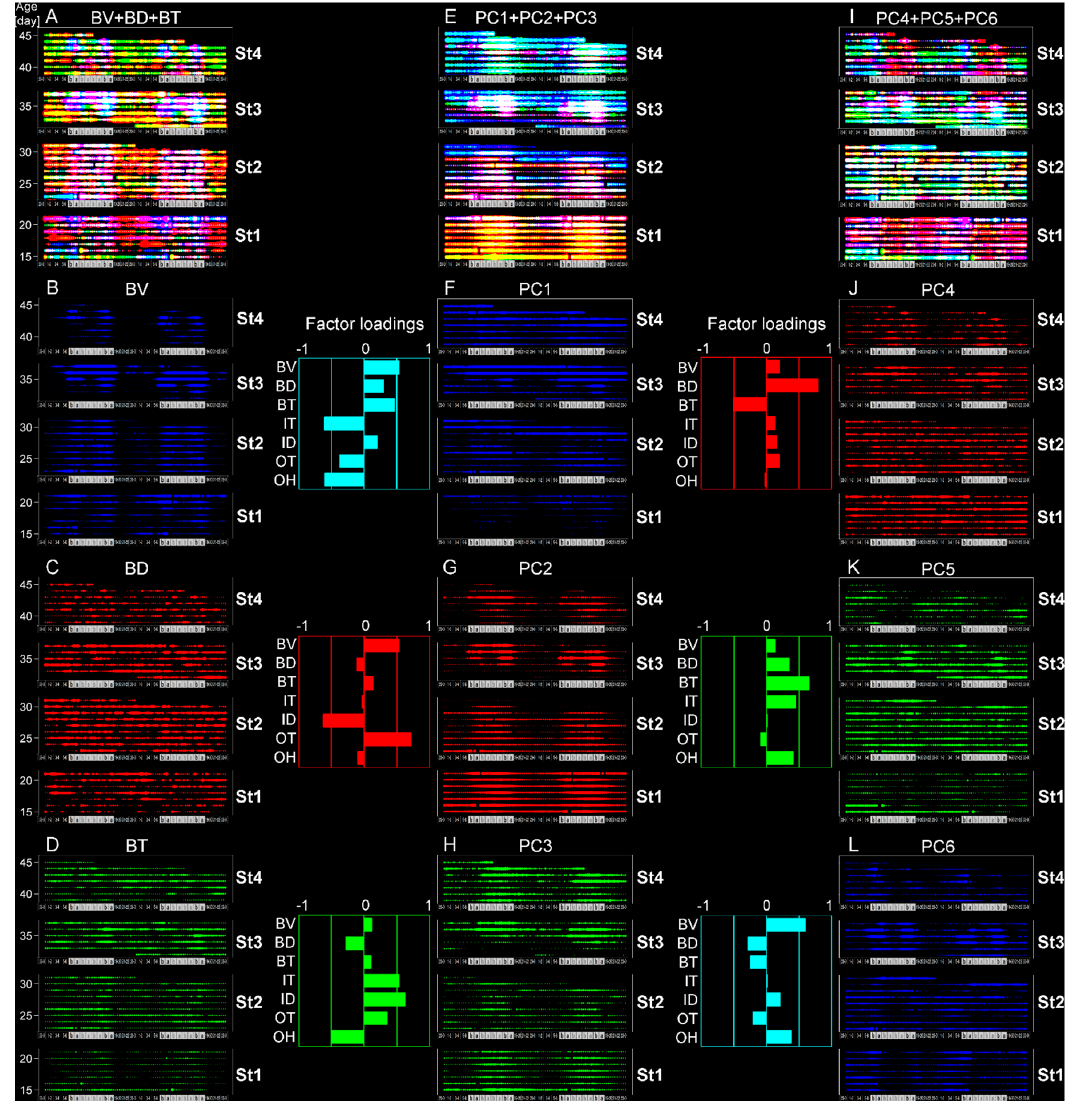
Figure 12. Characterization of complex circadian rhythms. Overlaid raster plots of BV (( B ), blue), BD (( C ), red) and BT (( D ), green), or PC1 (( F ), blue), PC2 (( G ), red) and PC3 (( H ), green), or PC4 (( J ), red), PC5 (( K ), green) and PC6 (( L ), blue) are depicted in ( A ), ( E ) or ( I ), respectively. Last, we compared the relevant B- to BD (Figure 10(A3) and B- to BT (Figure 10(A4)) pathways to the circadian BD-BT pattern, particularly in St4 (Figure 10(B4) (white arrow)) visualized by PC4–6 overlay (Figure 10(B5,B6)). Both MRNs emerged after morning feeding when infants were sated. Their behavior after feeding was different from than before feeding, presumably due to different expectations associated with the caregiver. Following morning feeding in St.4, we found two notable oppositely paired positive/negative correlating branches from the same night times and explanatory variables but different response-variable sets. One pair started BV from 5–6 a.m. as the night before morning in St1 (Figure 10(B5,B6,Ba)) and another, BD from 7 p.m. as the night beginning in St2 (Figure 10(B5,B6,Ba).The common MRN of BD and BT in St4 was consistently around the beginning of the PC4 (red) dominant phase because of the negative BD-BT correlation of PC4. This key pathway